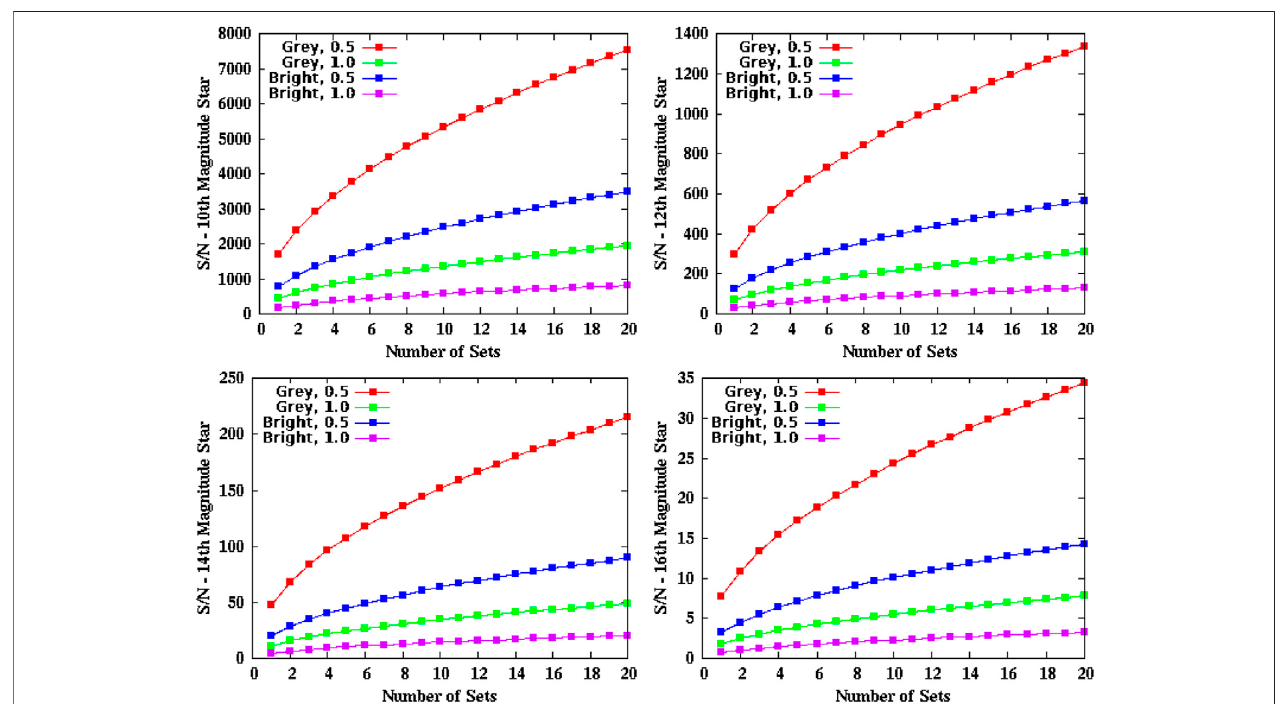
FIGURE 1 | S/N for targets with R-band magnitudes of 10, 12, 14, and 16 as a function of the number of 1,000 frames sets. The curves are color-coded by sky condition (Grey, Bright) and seeing value (0.5 ″ , 1.0 ″ ) as shown in the legend.